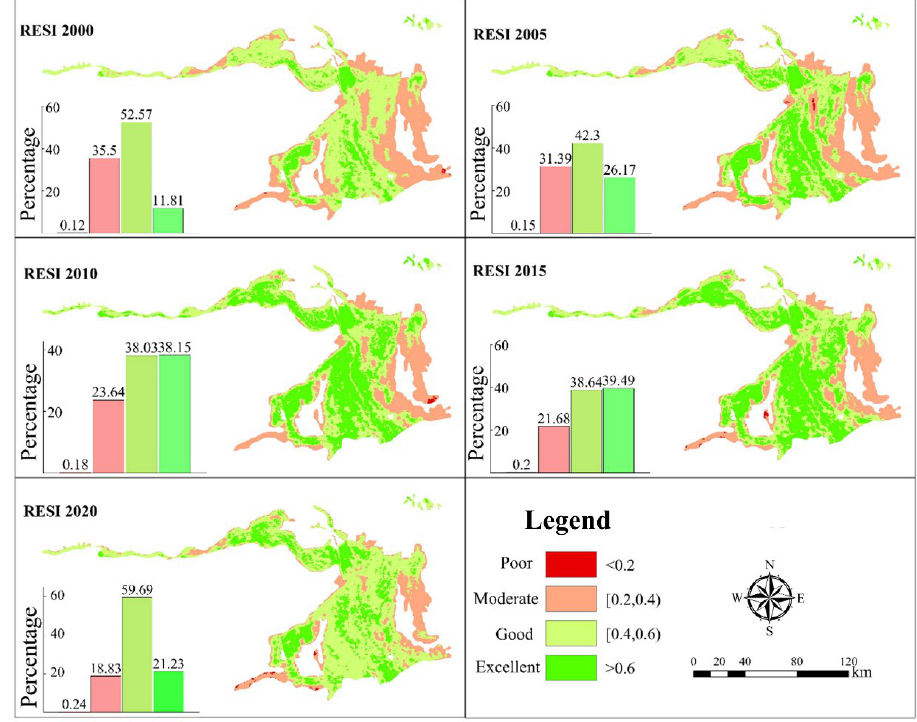
Water 2022 , 14 , x FOR PEER REVIEW